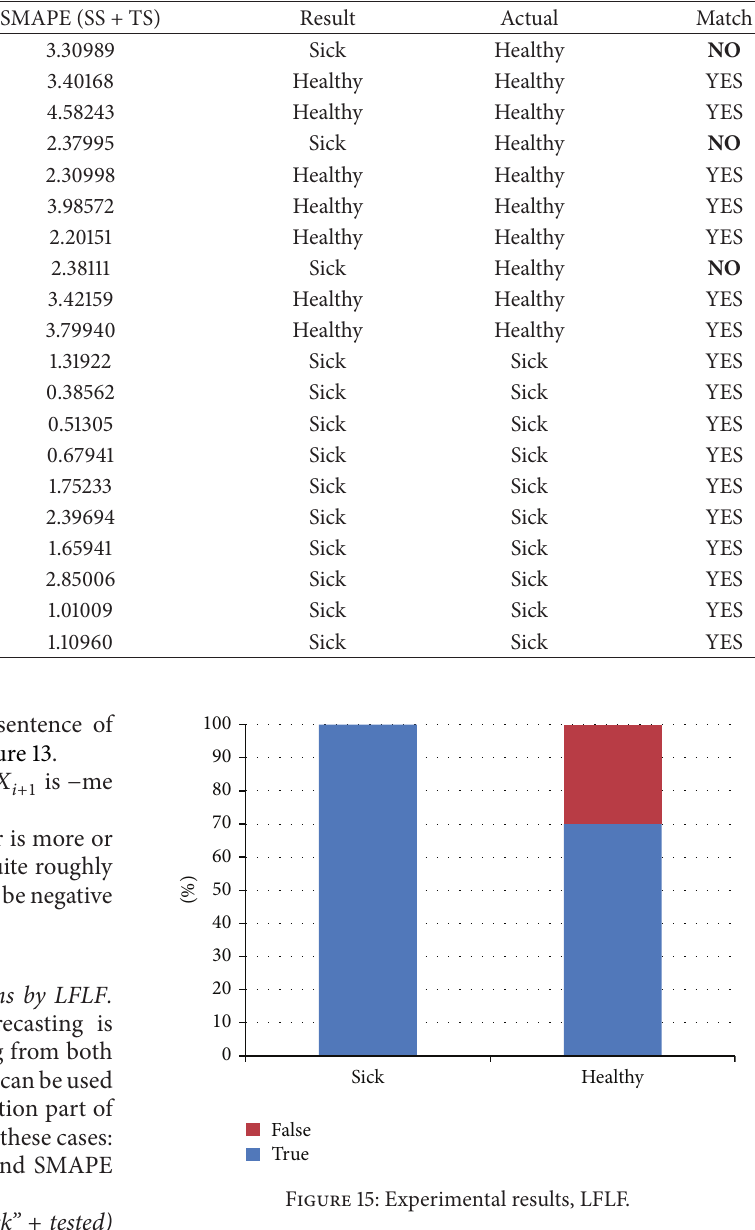
Table 2: Example of algorithm evaluation on 10 “healthy” and 10 “sick” patients.